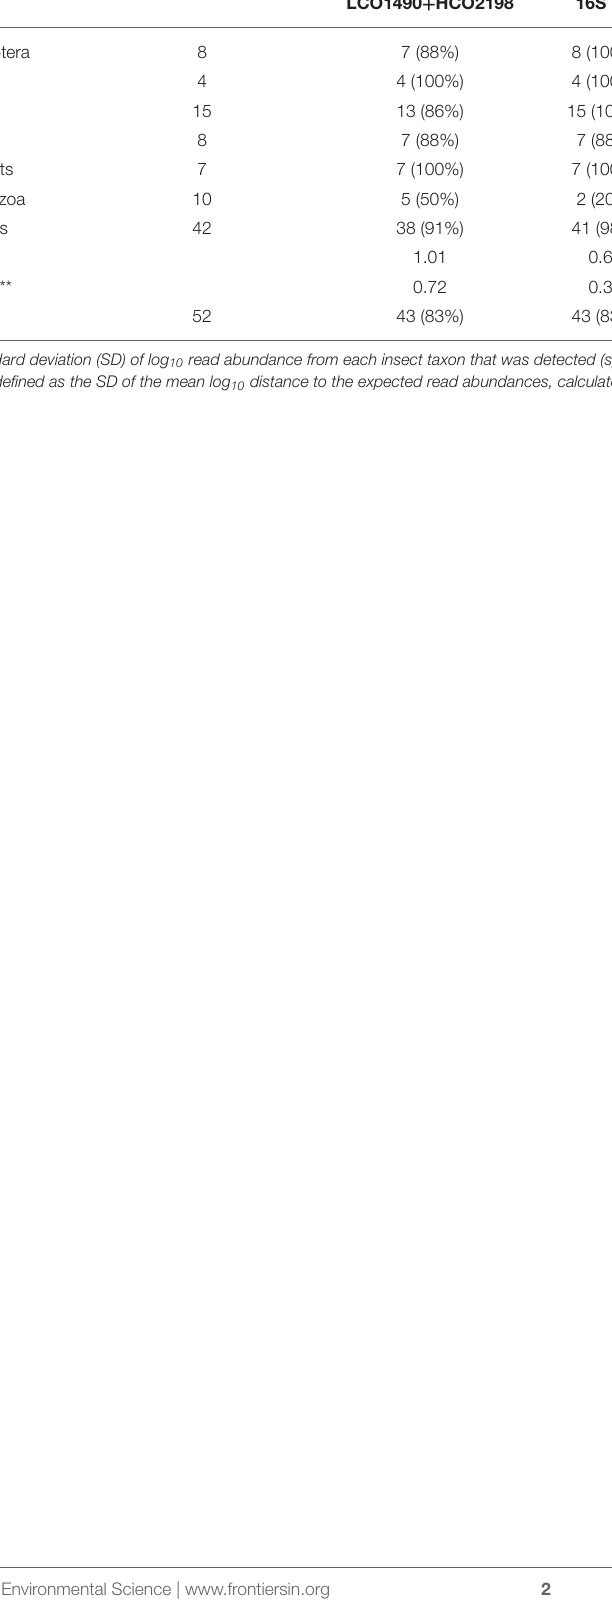
TABLE 2 | Number of species recovered with the newly developed primers and data on 16S and Folmer primers from previous tests (Elbrecht and Leese, 2015; Elbrecht et al., 2016). Taxonomic group Number of specimens Number of specimens recovered with specific primer combination LCO1490 +